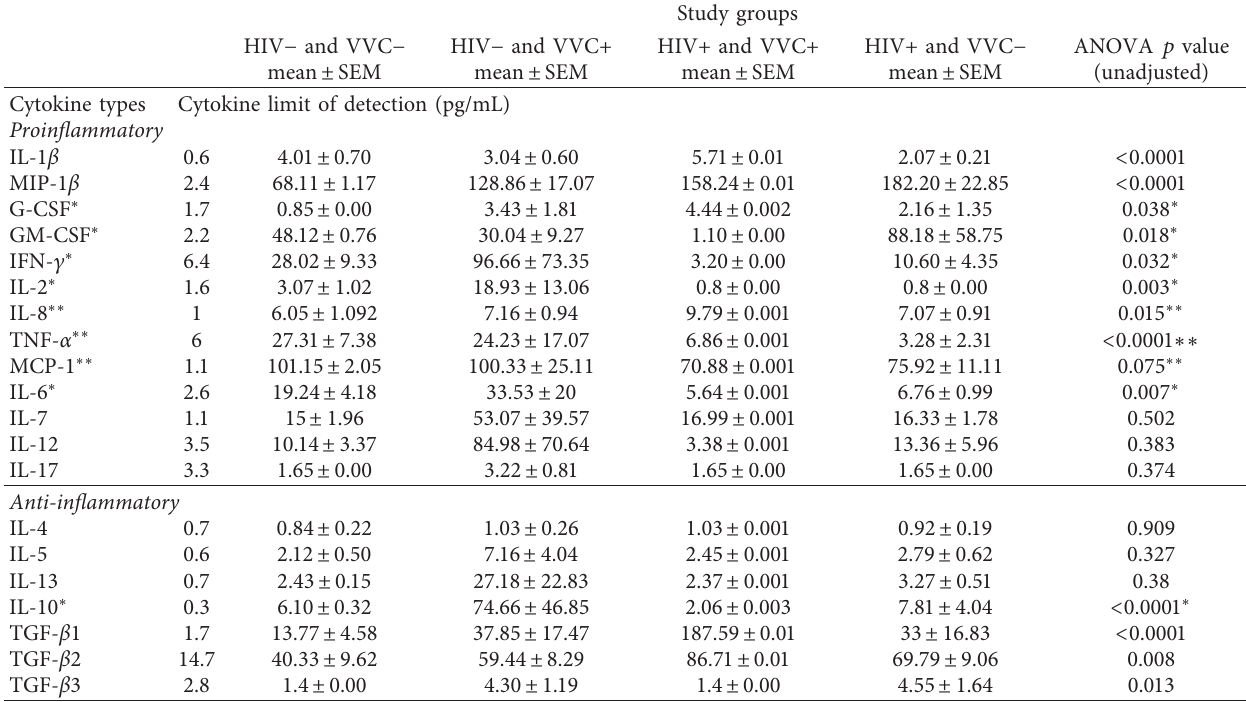
Table 1: Comparisons of the plasma mean levels (in pg/ml) of cytokines and chemokines across the study groups by HIV/VVC